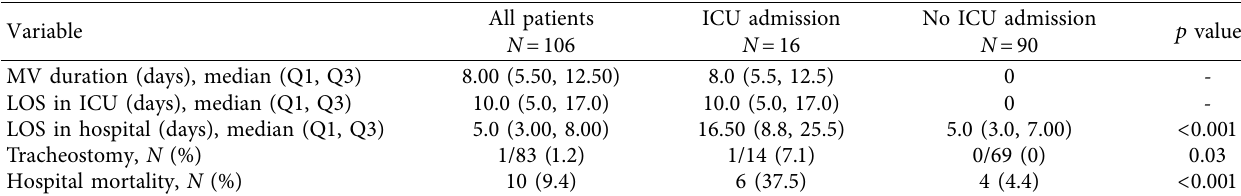
Table 3: Outcomes of